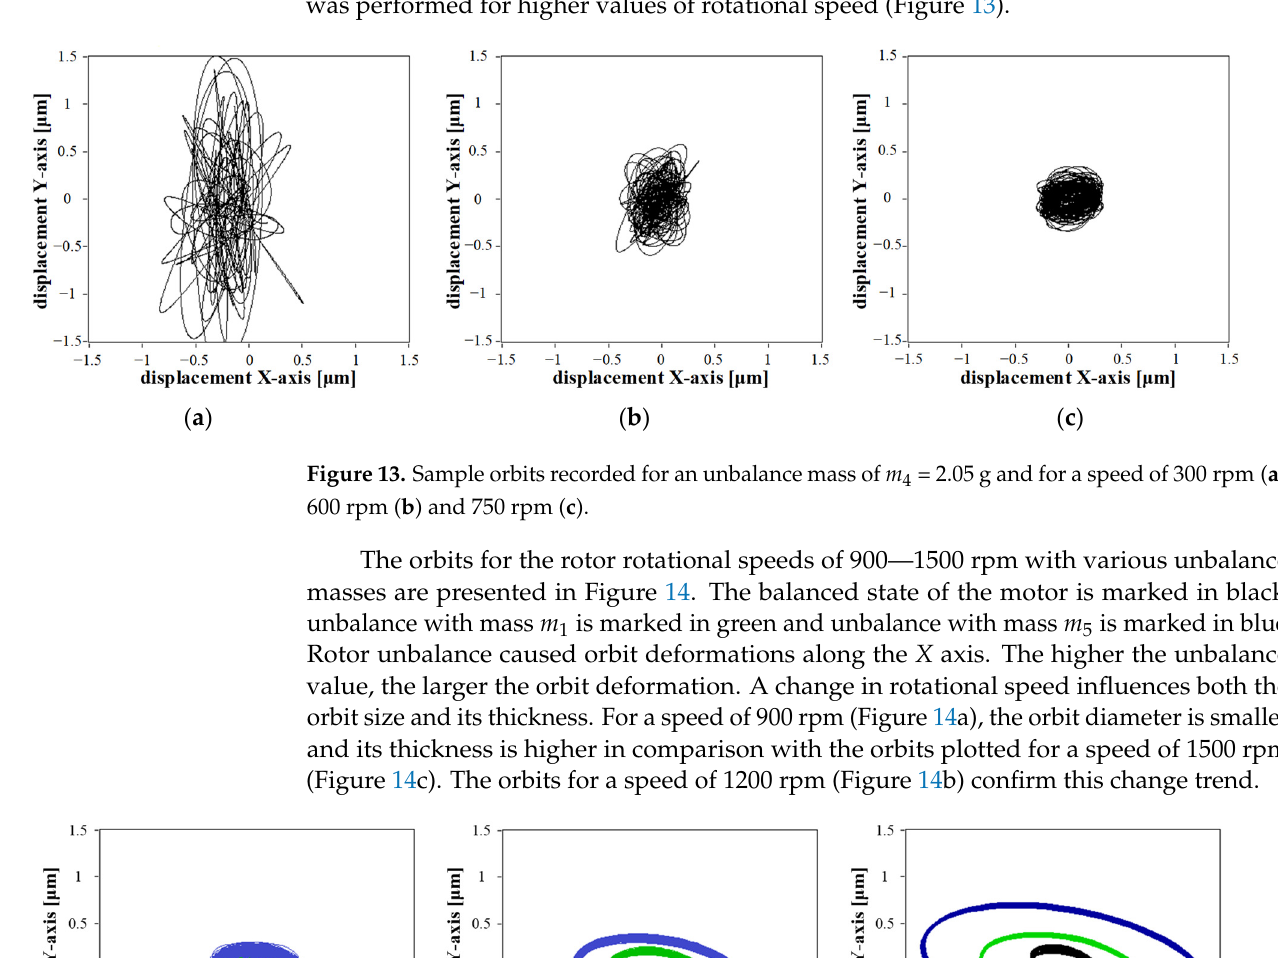
Figure 12. Backward (–1 X ) and forward (+1 X ) precession symptoms of rotor axis displacement as a function of changes of unbalance mass, m n ( a ), and rotational speed, n ( b ).